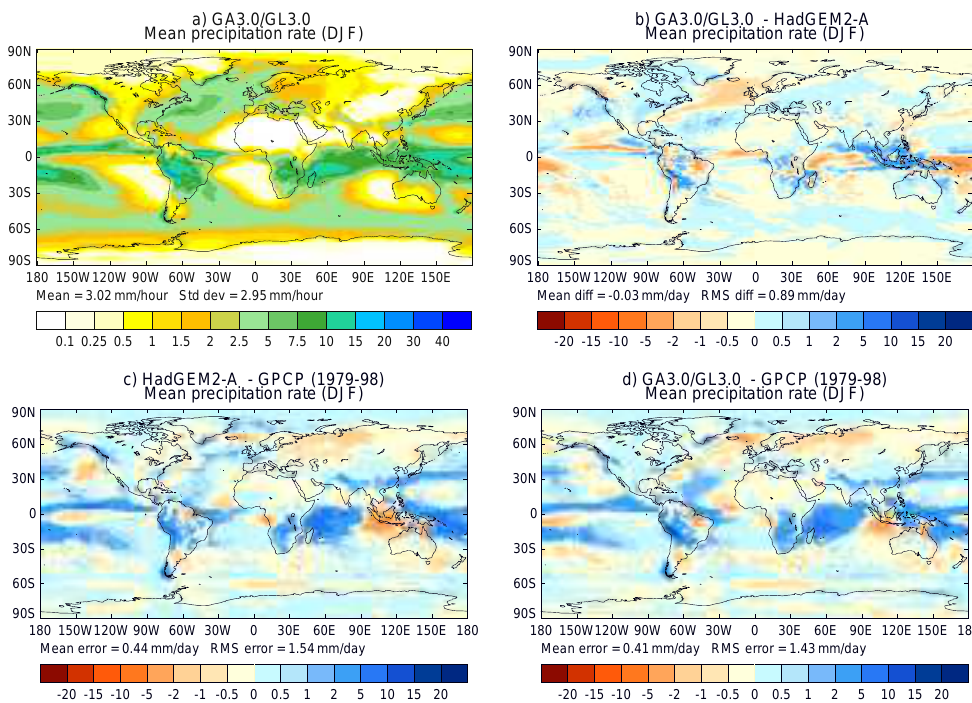
Fig. 6. Climatological precipitation during DJF in the 30 year N96 simulation using the same format as Fig. 3.